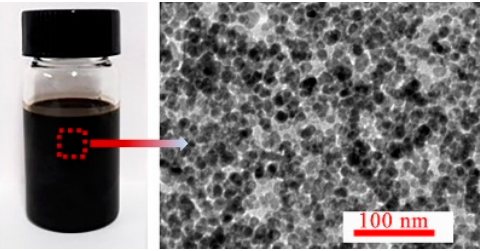
Figure 3. The TEM image of PFPE oil-based ferrofluids with w of 40wt%.